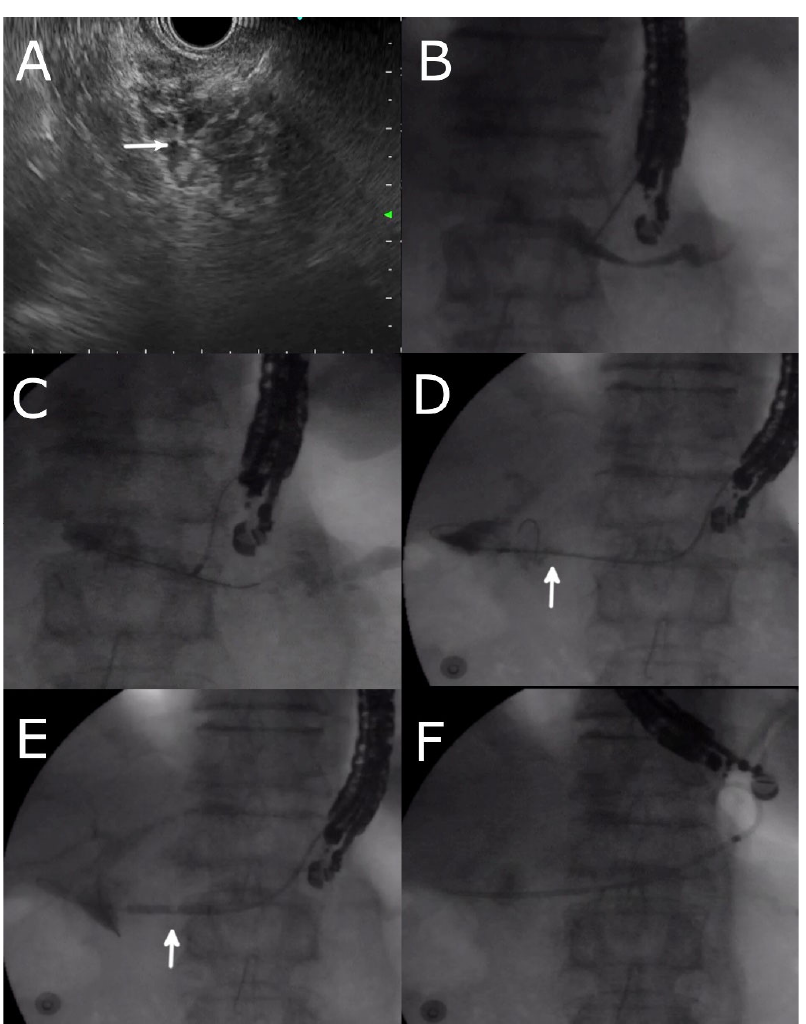
Figure 2. EUS ‐ guided drainage of a pancreatico ‐ jejunal anastomotic stricture after Whipple operation. ( A ) EUS ‐ guided puncture of the pancreatic duct (arrow indicates the position of the needle) ( B) Injection of contrast through the needle showing a pancreatogram. ( C ) Passage of guidewire and cystotome into the pancreatic duct. ( D ) Passage of the guidewire across the anastomotic stricture (indicated by the arrow) with the use of the cystotome as a pivot. Contrast injection through the cystotome outlined the jejunum and also part of the bile duct. ( E ) Dilation of the stricture with a 4 mm balloon (indicated by the arrow). ( F ) Placement of a plastic stent across the PJ anastomosis into the stomach.